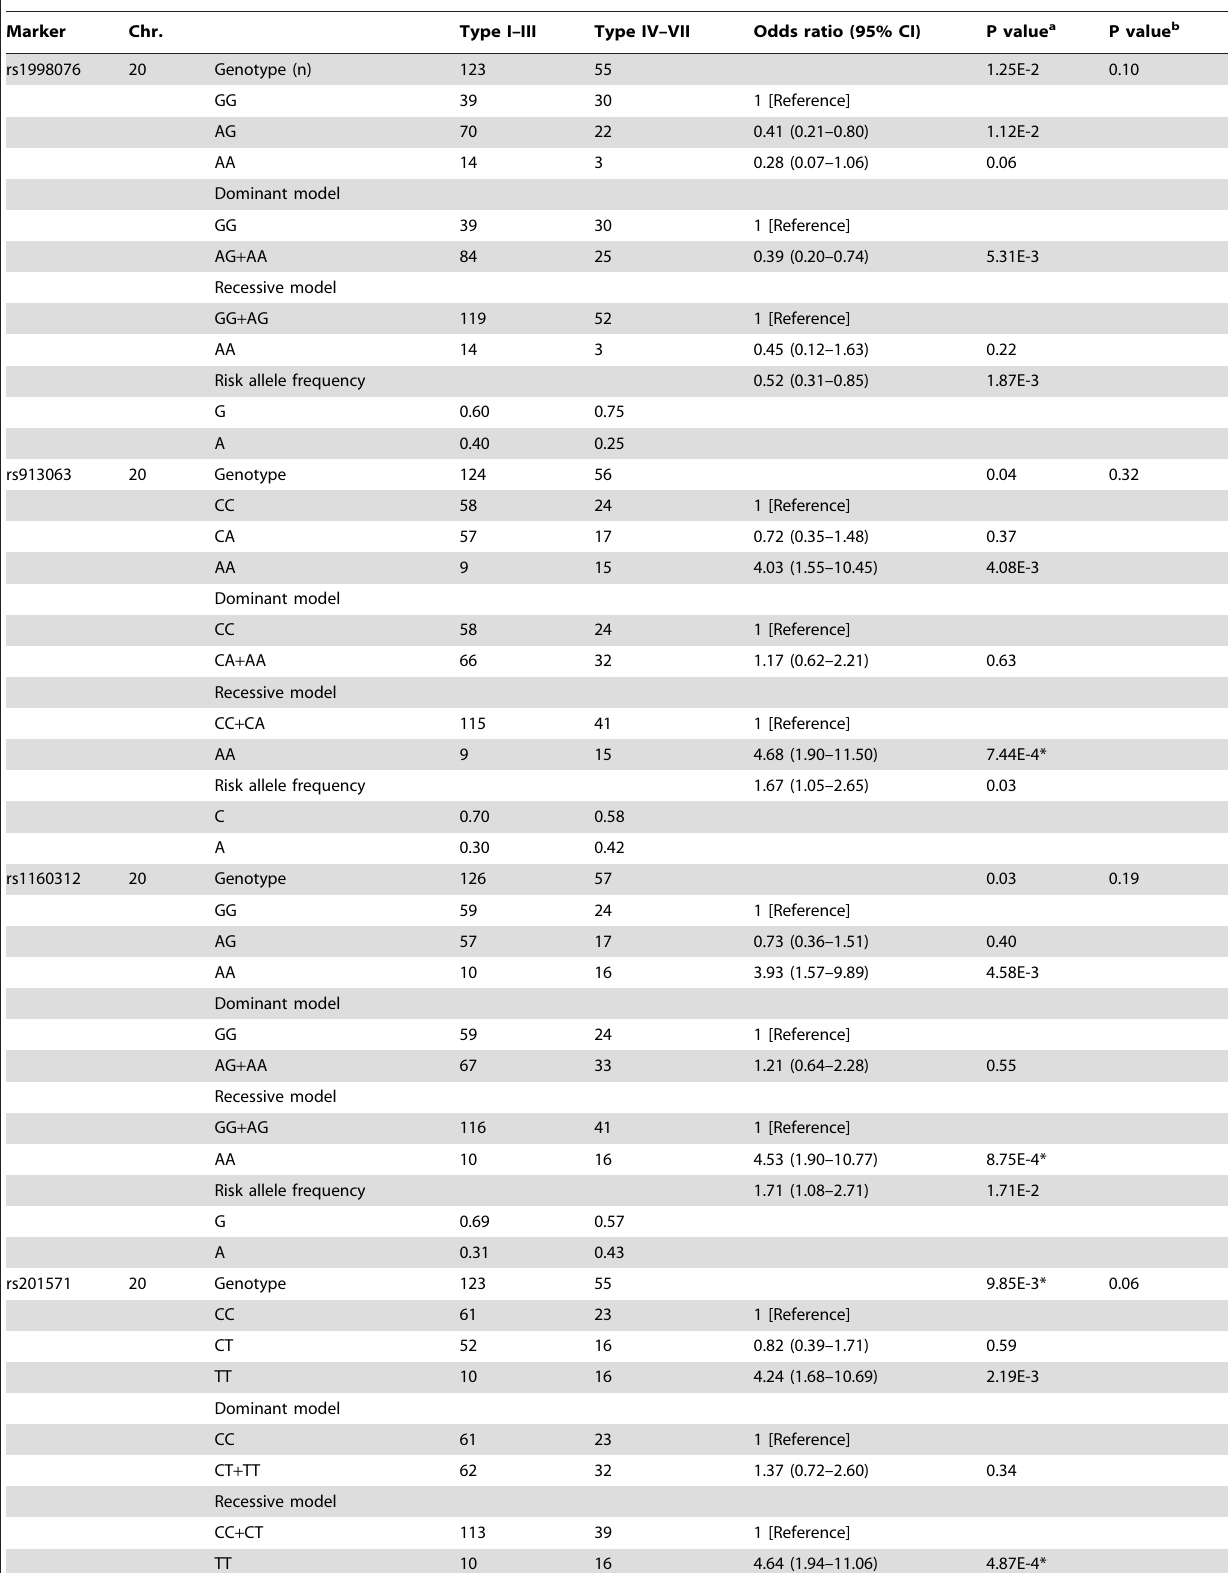
Table 4. Male AGA-associated genotypes and risk allele frequencies.